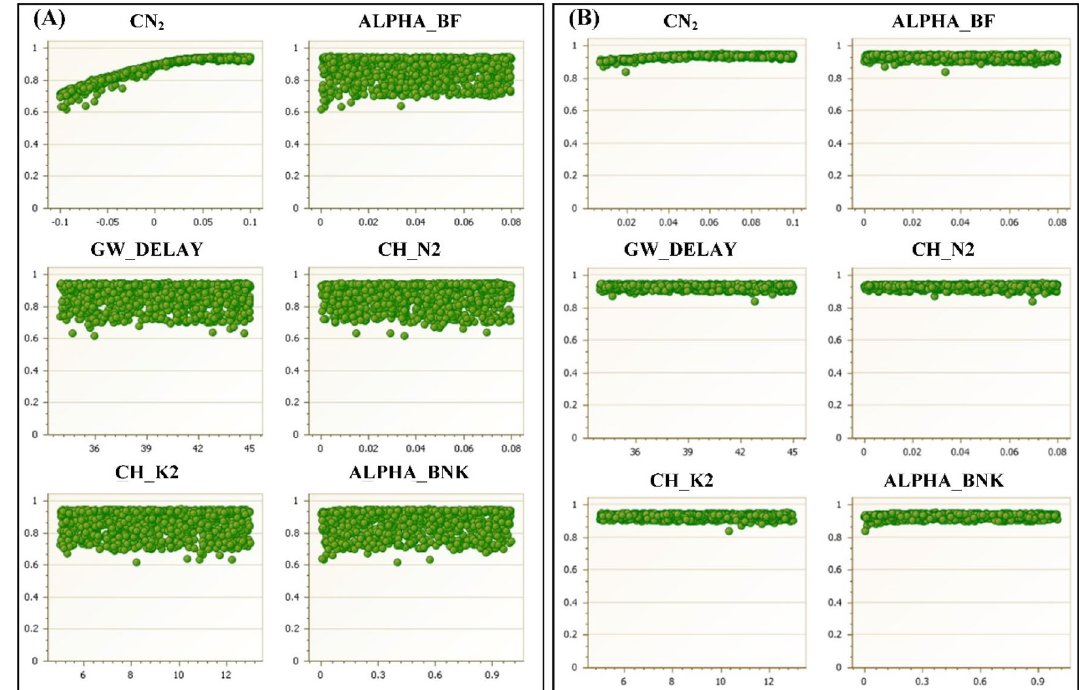
Figure 1. Parameter ranges of selected parameters in the first iteration ( A ) and second iteration ( B ).